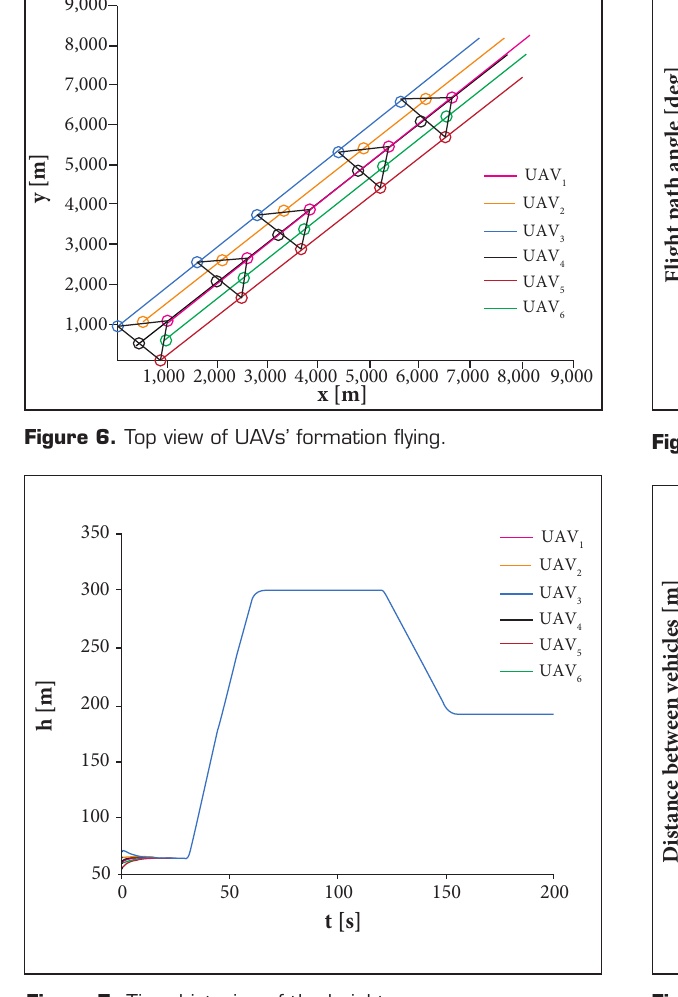
figure 9. Time histories of the distance between the UAVs.